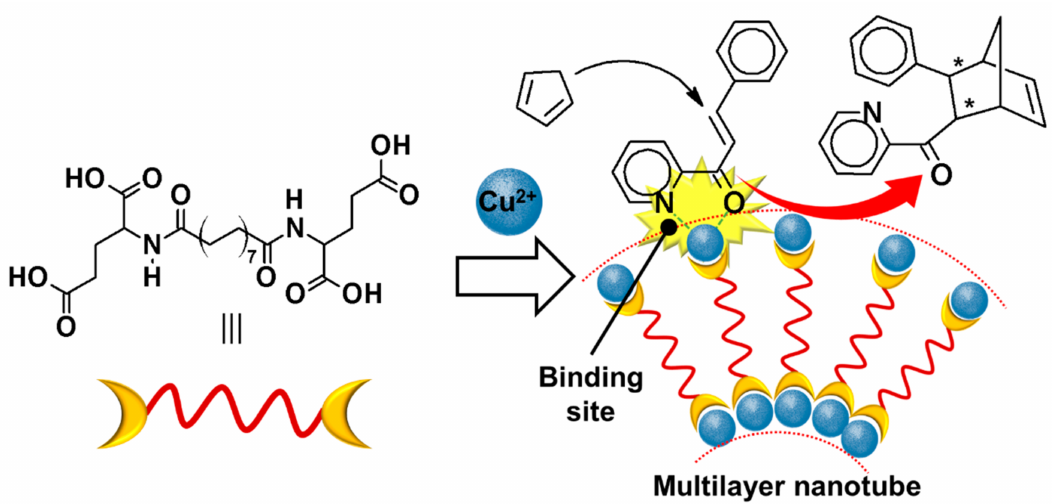
Figure 49. A metallogel N , N (cid:48) -hexadecanedioyl-di- L -glutamic acid/Cu(II)-catalyzed asymmetric Diels–Alder cycloaddition of aza-chalcone with cyclopentadiene.